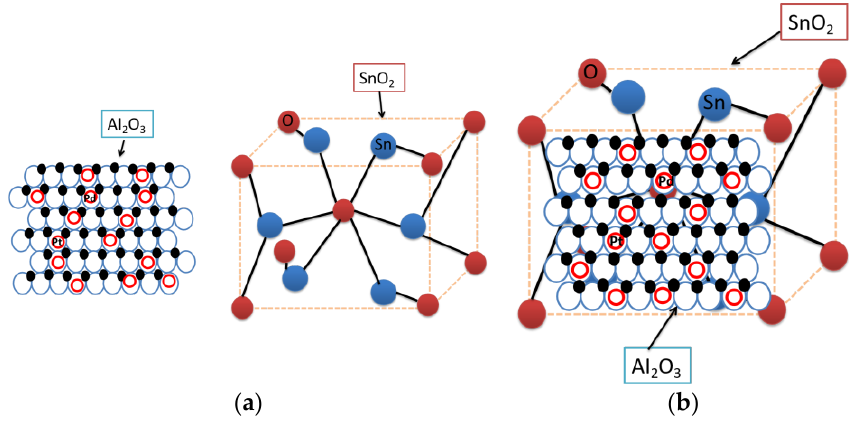
Figure 1. Schematic diagram of the material structure: ( a ) SnO 2 and Al 2 O 3 structure; and ( b ) SnO 2 /Al 2 O 3 composite structure.